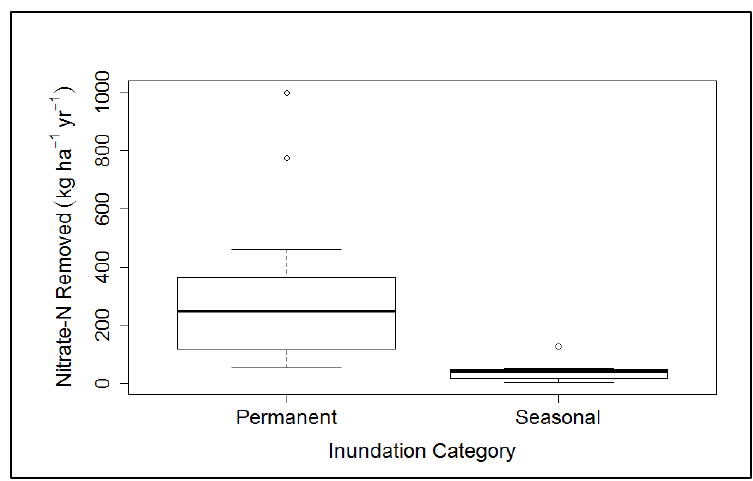
Figure 6. Nitrate-N (NO 3− -N) mass reductions in floodplains with areas of permanent inundation and floodplains with seasonal inundation. Lines from bottom to top: minimum, Q1, median, Q3, and maximum. Points: outliers.